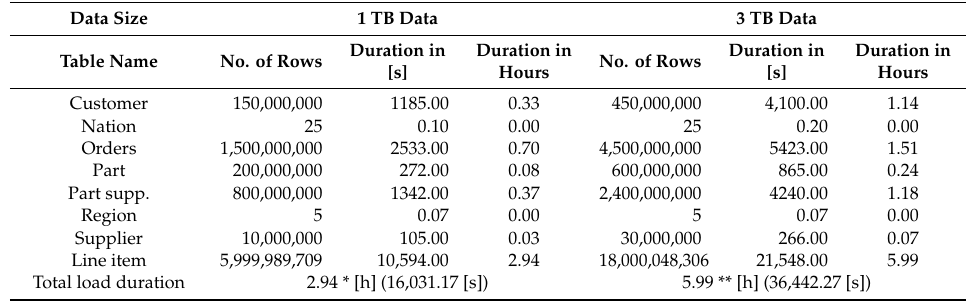
Table 2. Measured results compliant with TPC-H benchmarks for initial import of 1 TB and 3 TB test databases.